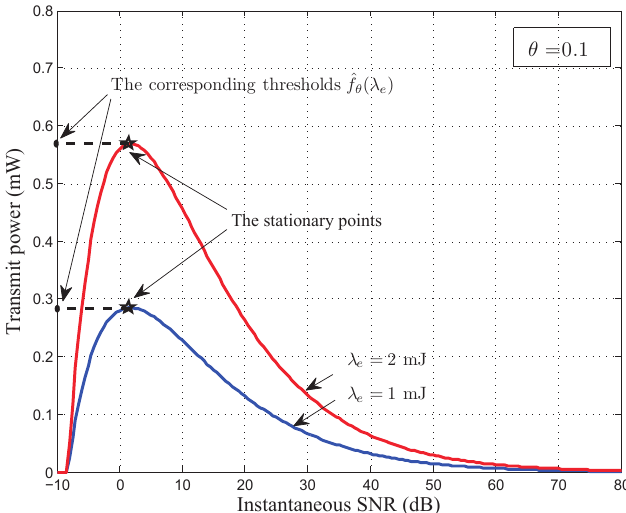
Figure 5. The transmit power curves versus instantaneous SNR to show the threshold ˆ f θ ( λ e ) under θ = 0.1.